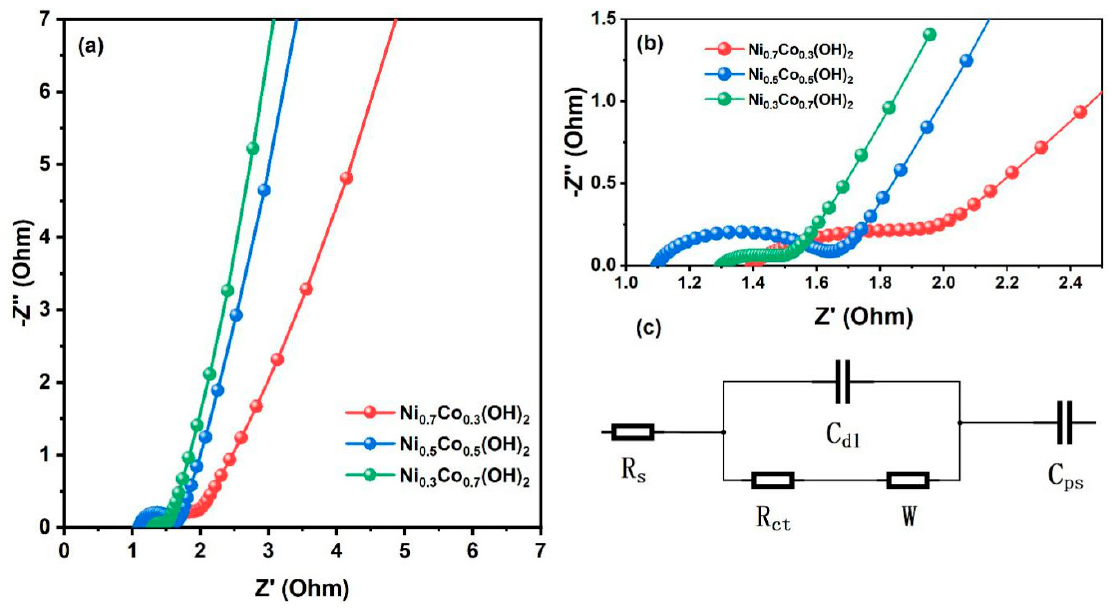
Figure 7. ( a ) Electrochemical impedance spectroscopy (EIS) plots of the Ni 0.7 Co 0.3 (OH) 2 , Ni 0.5 Co 0.5 (OH) 2, and Ni 0.3 Co 0.7 (OH) 2 electrodes. ( b ) Enlarged view of the high frequency region. ( c ) Fitting equivalent circuit.